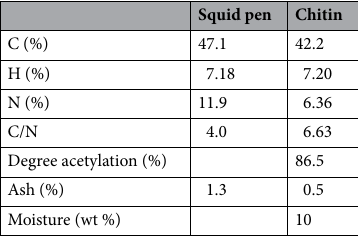
Table 2. Raw and digested chitin.